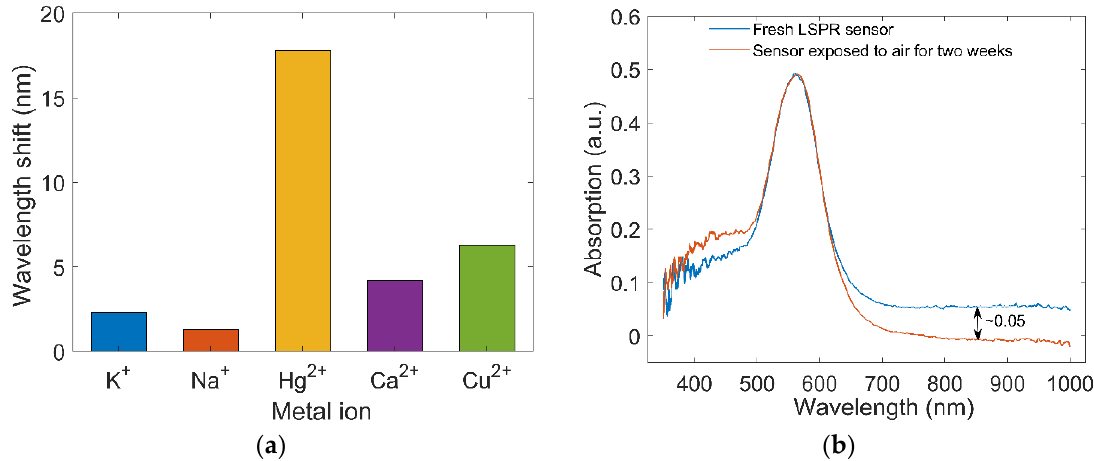
Figure 7. Specificity and stability of the proposed heavy metal sensor ( a ) wavelength shift of the LSPR sensor in di ff erent ion solution with a concentration of 30 µ M; ( b ) absorption spectra of the LSPR sensor tested immediately versus the one exposed to air for two